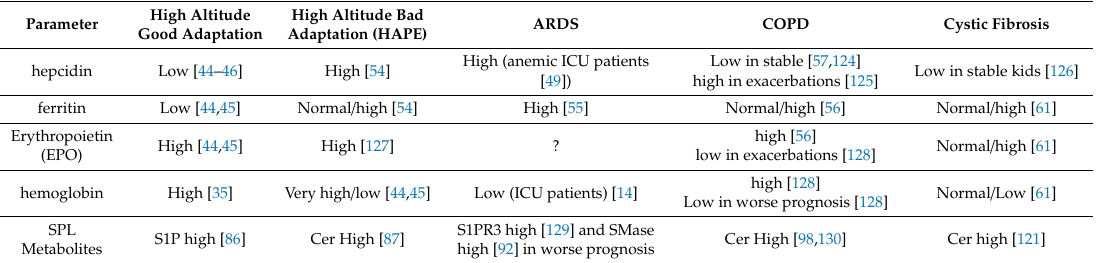
Table 1. Iron and SPL metabolism markers and their trend in comparison to the normal values, in response to di ff erent hypoxic